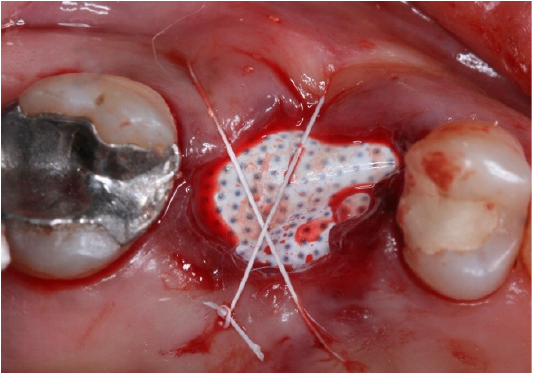
Figure 16. Intra-oral oclusal view of #16 with dense PTFE barrier installed to seal the alveoli and sutured with PTFE thread.